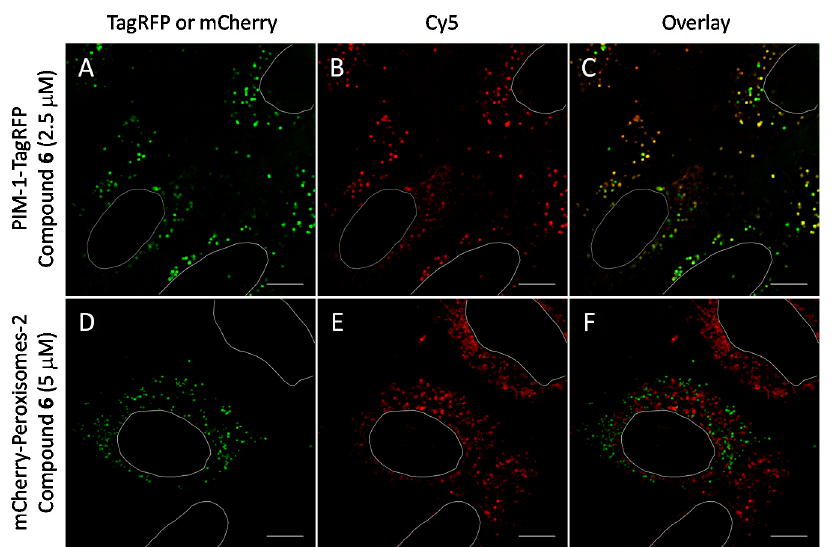
Figure 6. Co-localization studies of PIM-targeting compound 6 with fluorescent protein-tagged PIM-1 and peroxisomal marker (following 48 h transfection) in live U2OS cells. The PIM-1-mRFP and mCherry-Peroxisomes-2 are shown in green and compound 6 is shown in red. White ovals indicate nuclei borders. Individual channels and overlayed images: ( A – C ) PIM-1-TagRFP and compound 6 (2.5 µ M, 1 h incubation); ( D – F ) mCherry-Peroxisomes-2 and compound 6 (5 µ M, 1 h incubation). Representative images (in cells with low expression of constructs) from two independent experiments are shown. Scale bar: 10 μ m.